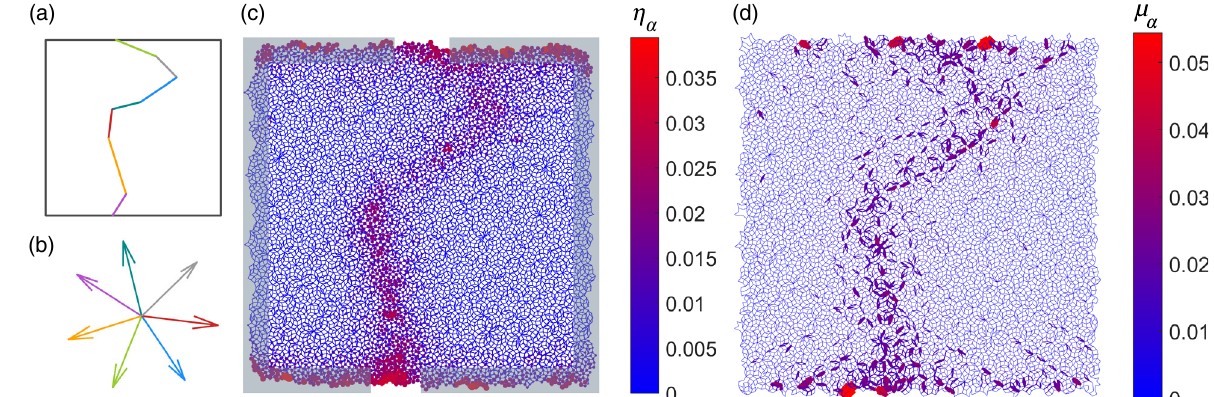
FIG. 7. Topological waveguiding and stress focusing using quasicrystalline tilings. (a) Target waveguide with an irregular shape, with different straight line segments marked by different colors. (b) Star vectors are chosen such that every star vector is perpendicular to a line segment (marked by the same color). (c) Quasicrystalline parallelogram tiling generated using these star vectors. This tiling has topological FMs localized at the interface for waveguiding. Zero-mode weights η α on each node are shown using both the color and size of the disks (same convention as in Fig. 1). The modes are calculated using open boundary conditions. The blue shaded strips illustrate the geometry for waveguiding, where the boundary sites are fixed except at the input and output areas. (d) Choosing opposite topological polarizations from (c) leads to topological SSSs at the interface. The SSS weights μ α on each edge are shown by both color and thickness. Fixed boundary conditions are used for this SSSs calculation, yielding information on stress distribution when the structure is subject to external